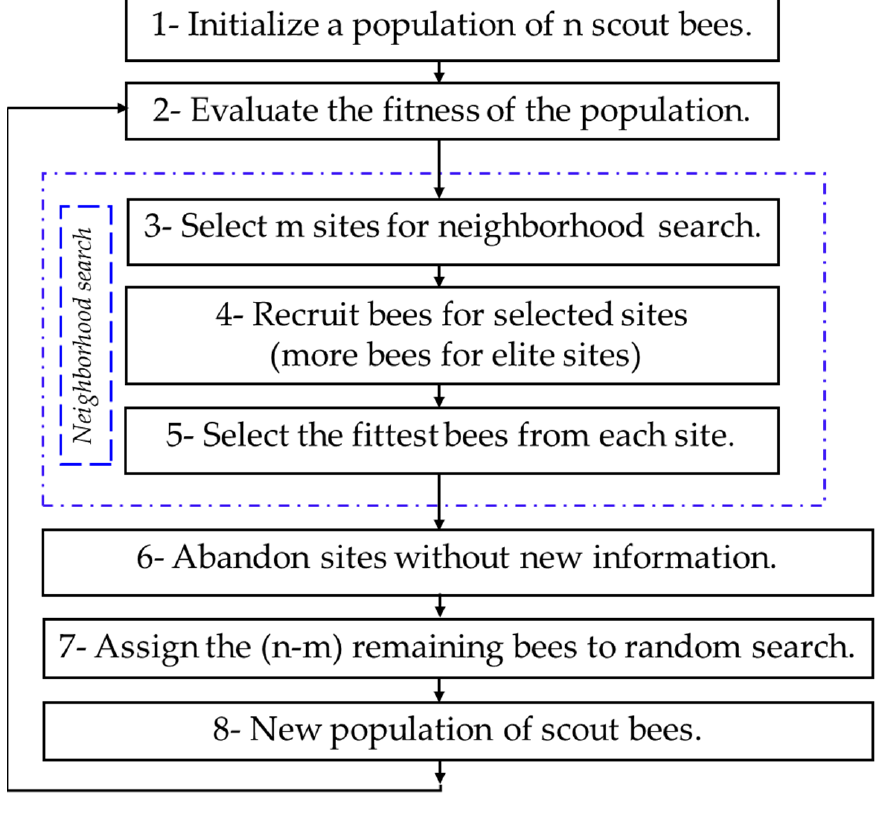
Figure 4. The Bees Algorithm flowchart.